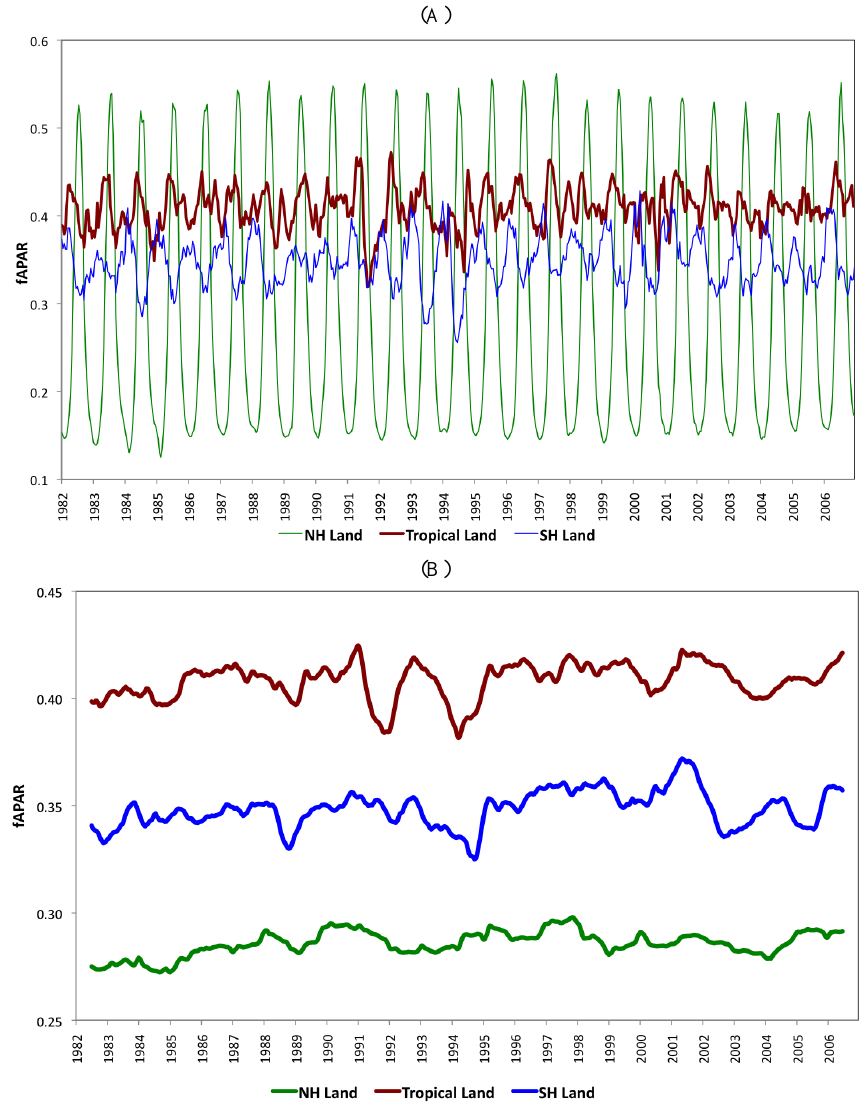
Fig. 4. Integrated fAPAR time series calculated from GIMMS NDVI across three latitudinal bands: (A) time series of the full-temporal variability of fAPAR, (B) time series of the running annual average (box-car filter) of fAPAR. For a map of the regions see Fig.